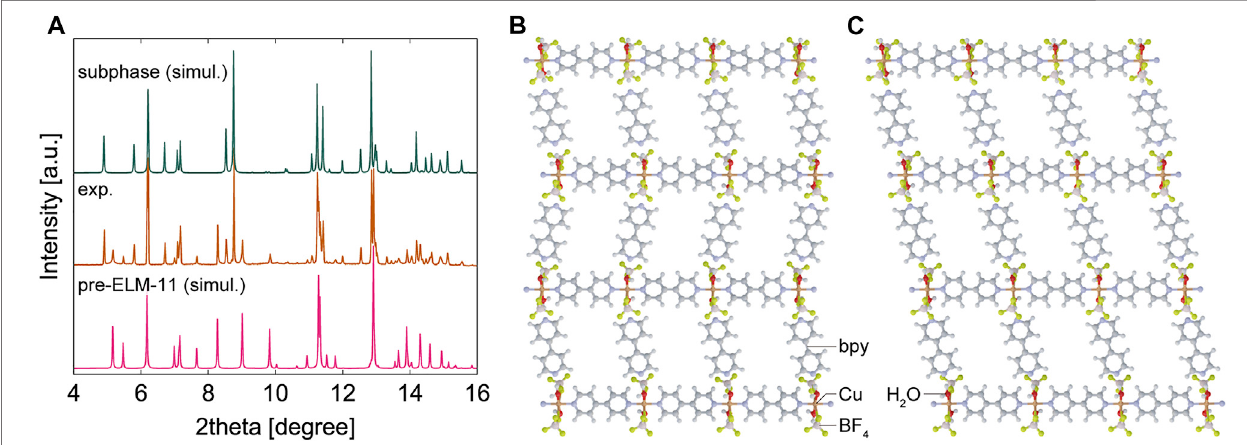
FIGURE 2 | Results of structural analyses. (A) Simulated XRD patterns of structural models for pre-ELM-11 and the isomeric subphase in comparison with a synchrotron XRD pattern of as-synthesized particles from “ synthesis-II ” condition that contained the two structural phases. We used the as-synthesized particles from “ synthesis-II ” condition instead of air-exposed samples because a stronger and sharper peak pro fi le was obtained, which was suitable for detailed structural analyses. Top view of 2D layer of structural models for (B) pre-ELM-11 and (C) the isomeric subphase.